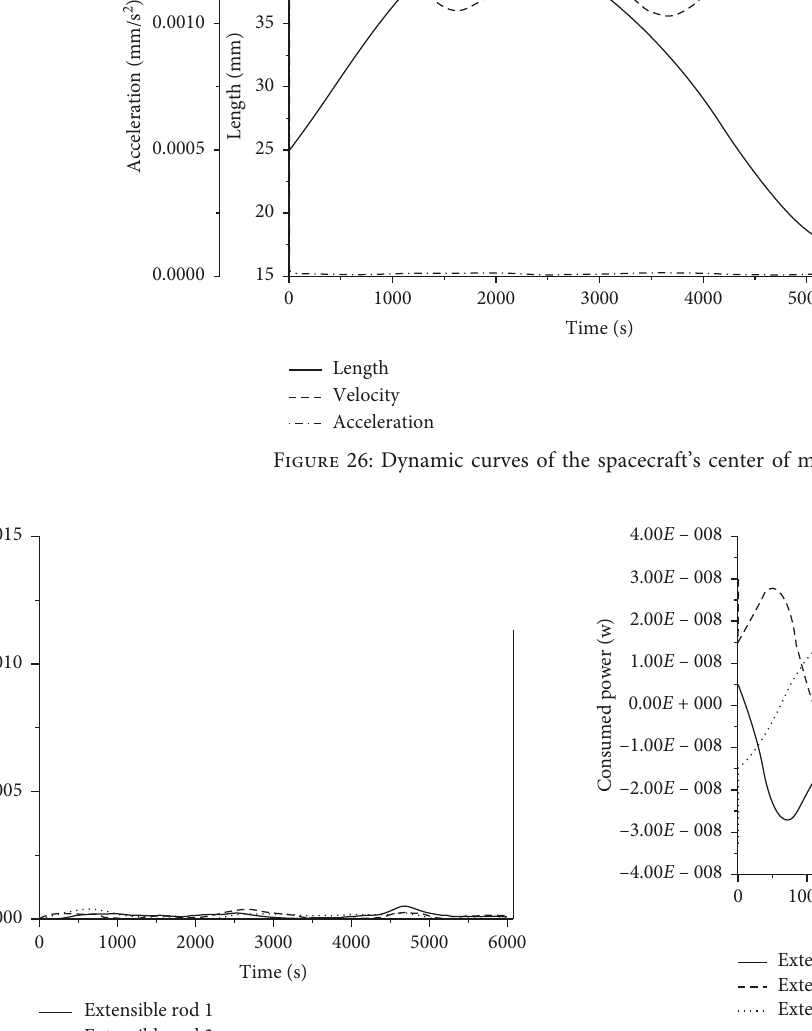
Figure 28: Consumed power of each extensible rod with